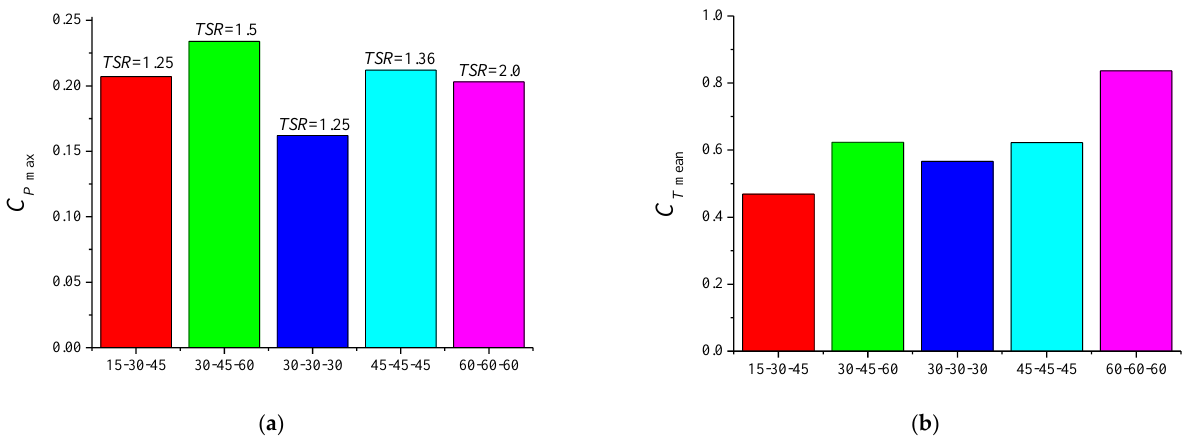
C for the five ASWT rotors: ( a ) C and m ea n T m a x P P max and C T mean for the five ASWT rotors: ( a ) C P max ; ( b ) C T mean